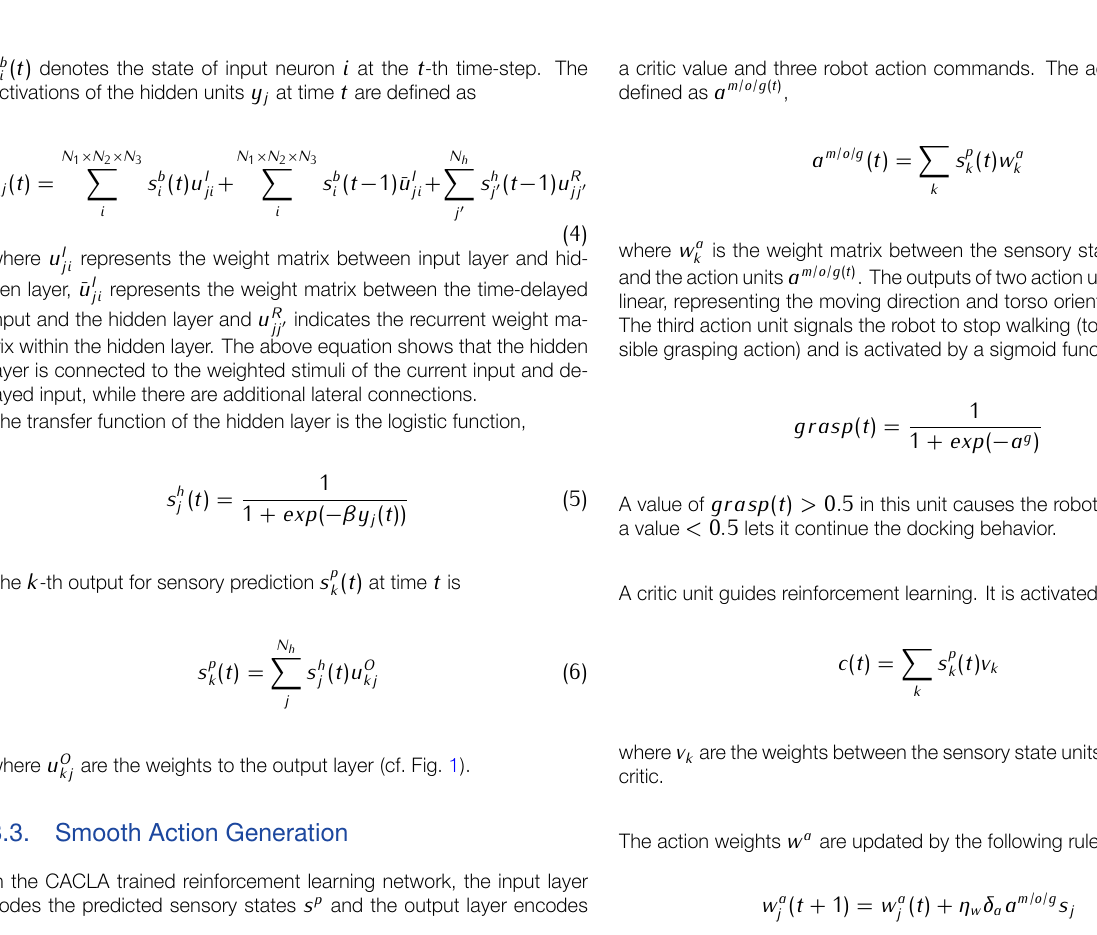
Figure 3. Shelf installation / docking station. After docking, the robot could grasp some object from the shelf.